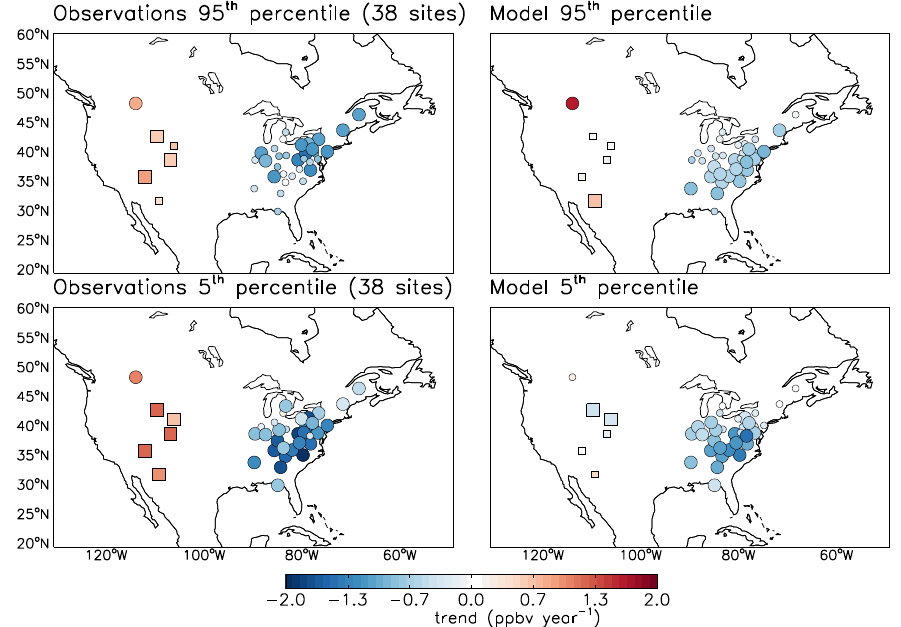
Table 03. Simulations performed with the GEOS-Chemmodel in the present work.